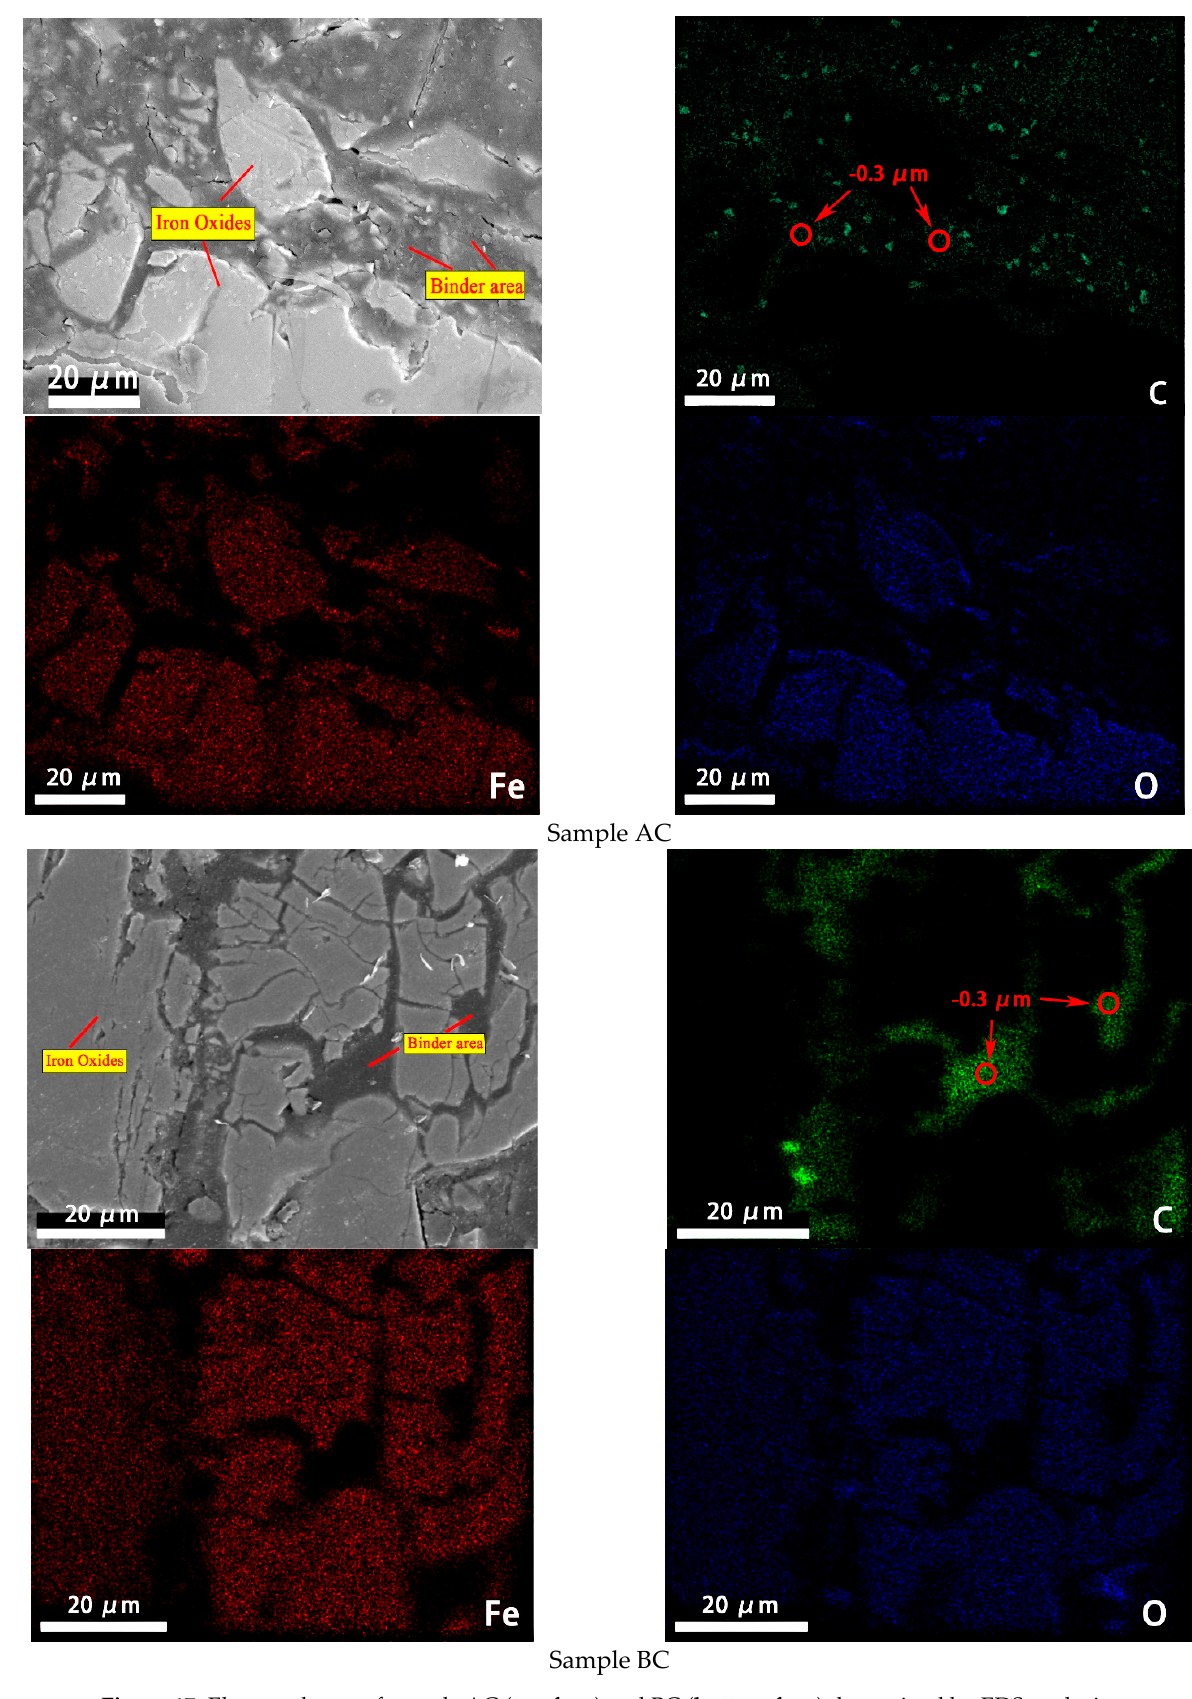
Figure 17. Elemental map of sample AC ( top four ) and BC ( bottom four ) determined by EDS analysis.